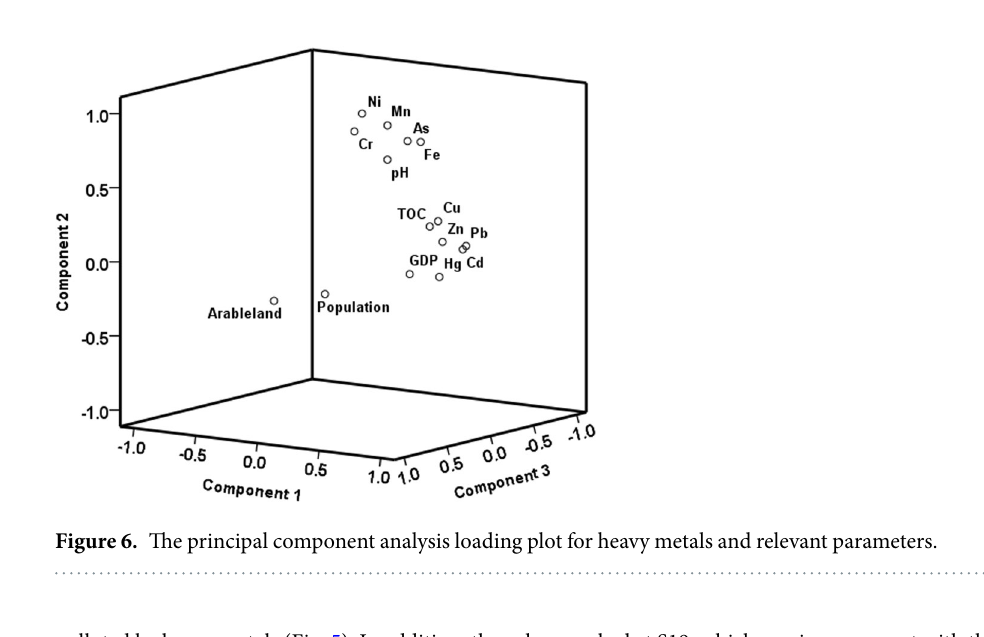
Figure 5. PLI values for heavy metals at different sampling sites.